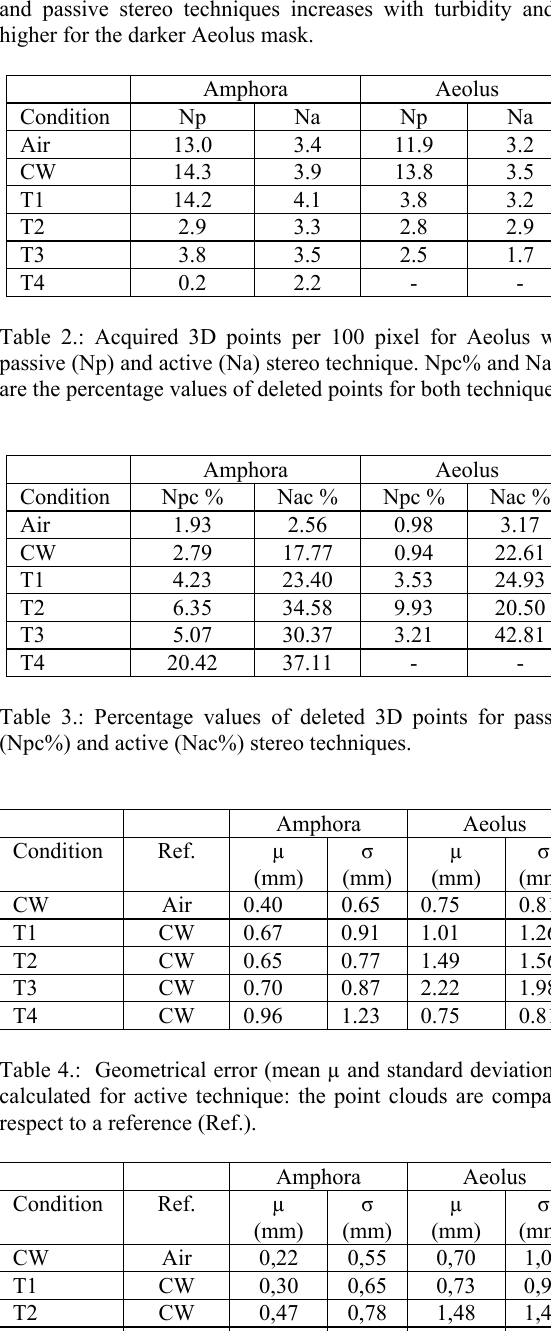
Figure 7. Images of Amphora and Aeolus acquired in turbid water with ambient illumination and projecting a pattern.